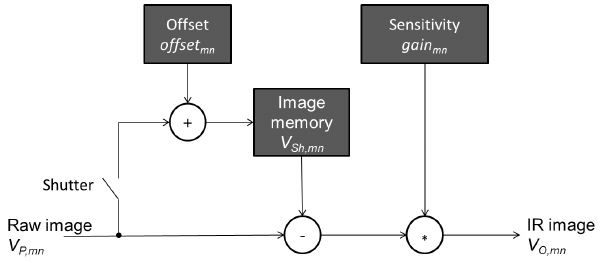
Figure 3. Camera model for the calculation of the IR image (expla- nation in